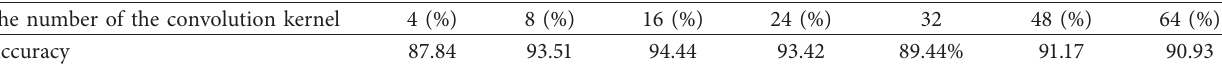
Table 5: Influence of the size of convolution kernels in RBUs on the 1D-WDRSN model.